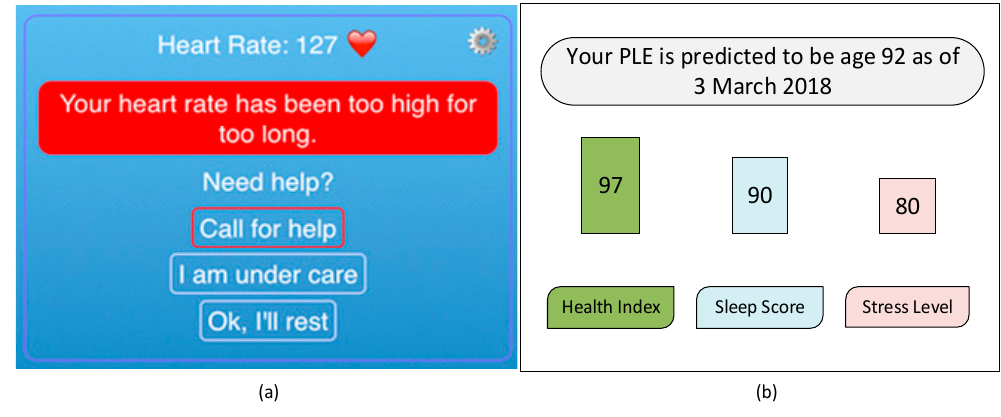
Figure 7. mHealth mobile app screens (example). ( a ) Existing health mobile app can integrate PLE feature as additional services ( b ) as both functions require the same physiological data to transfer to a monitoring center for PLE calculation.